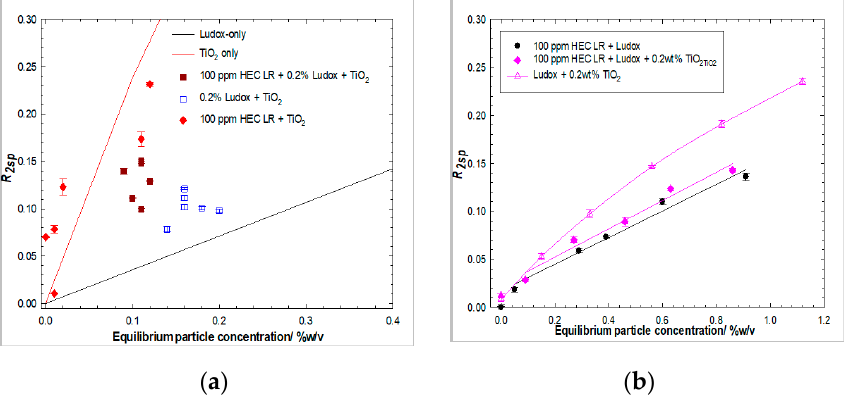
Figure 8. Solvent-specific relaxation rates of Ludox/TiO 2 binary particle systems in the absence and presence of 100 ppm HEC LR post centrifugation, for fixed Ludox (left hand side, 8( a ) and fixed TiO 2 (right hand side, 8( b )) concentrations.